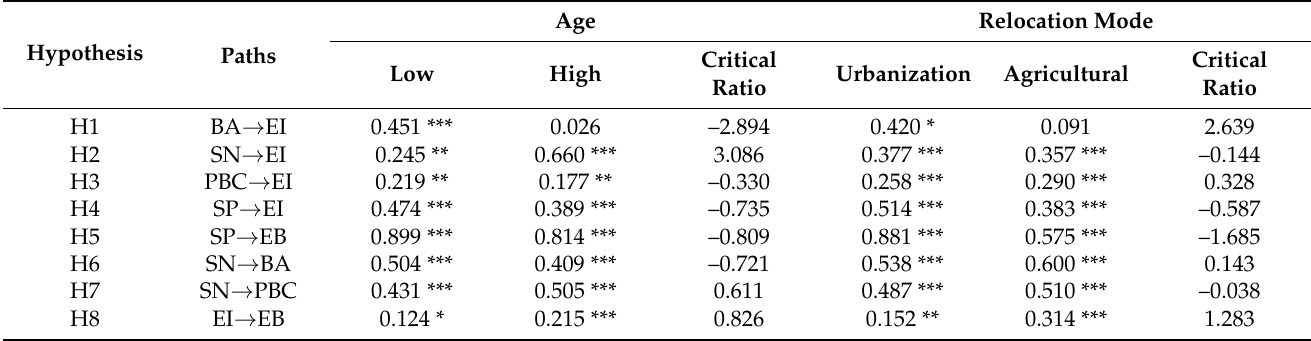
Table 8. Test of Age and Relocation Effect on the